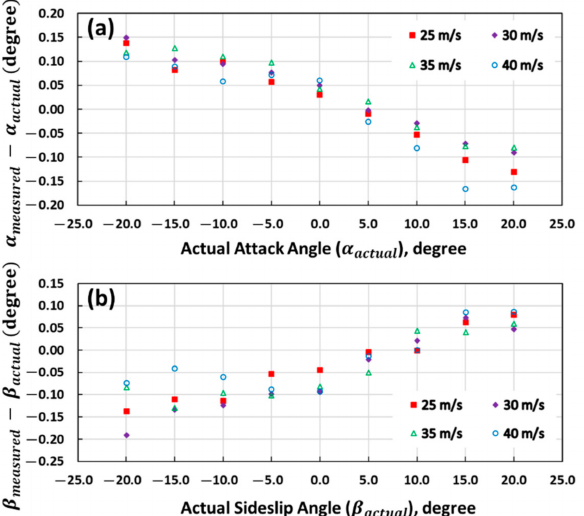
Figure 6. Wind tunnel test error curve for attack angle ( a ) and sideslip angle ( b ), where the y axis is the difference between the measured and actual angles. The inset indicates the nominal airspeeds in the wind